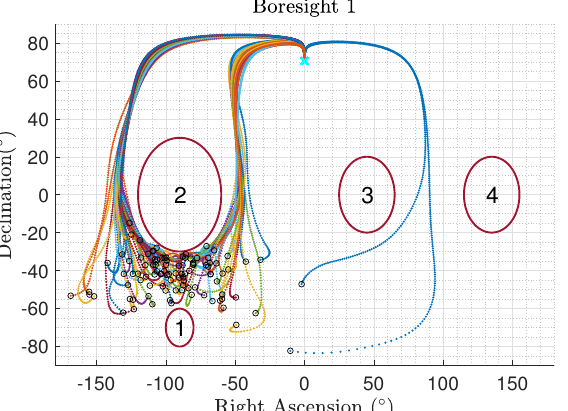
Figure 17. Monte Carlo results for sensitive equipment placed in the x-body axis (Boresight 1). The Inclusion Constraint is removed from the simulation.